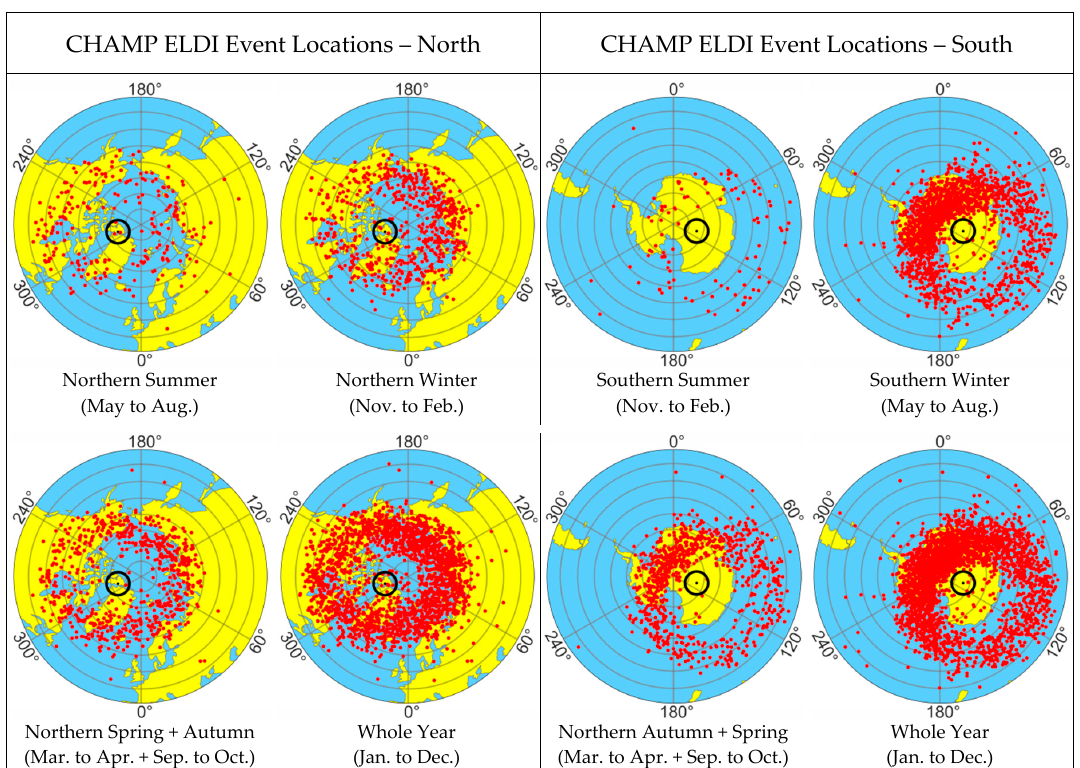
Figure 5. Geographic locations of ELDI events (red dots) for CHAMP superimposed for 2001 to 2008. Black circles mark the locations of the geomagnetic poles. ( Left panel ) northern high latitude region, ( right panel ) southern high latitude region. ( Top left maps ) summer season; ( top right maps ) winter season. ( Bottom left maps ) a combination of spring and autumn seasons; ( bottom right maps ) whole year.